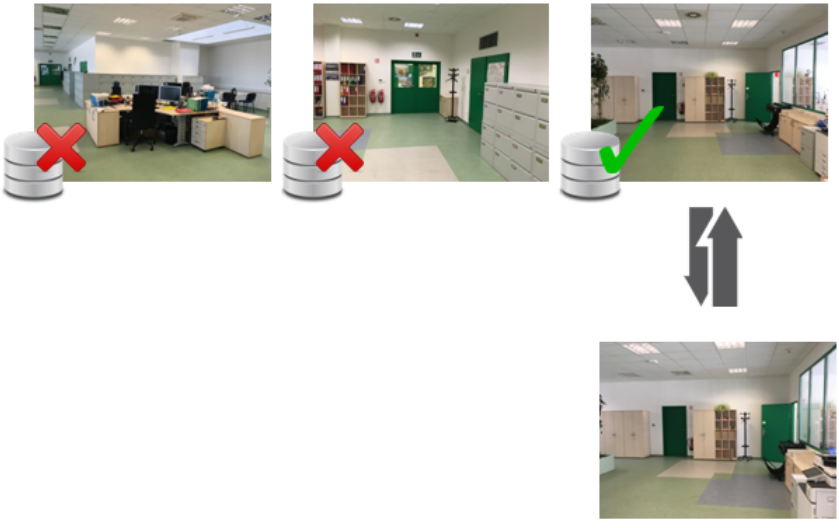
Figure 5. Best matching database image selection.